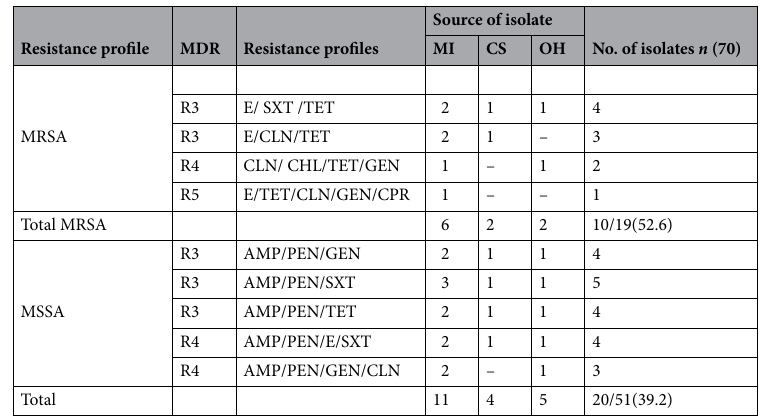
Table 3. Multidrug resistance profile of nasal MRSA isolates among Medicine and Health Science Students of Arba Minch University, Arba Minch, southern Ethiopia, 2020. PEN: penicillin, CPR: ciprofloxacin, CLN: clindamycin, GEN: gentamicin, E: erythromycin, CHL: chloramphenicol, AMP: ampicillin, TET: tetracycline and SXT: trimethoprim-sulfamethoxazole, MI: Medical intern, CS: clinical students, OH: other health students, R3: resistant to 3 antibiotics, R4: resistant to 4 antibiotics, R5: resistant to 5 antibiotics.